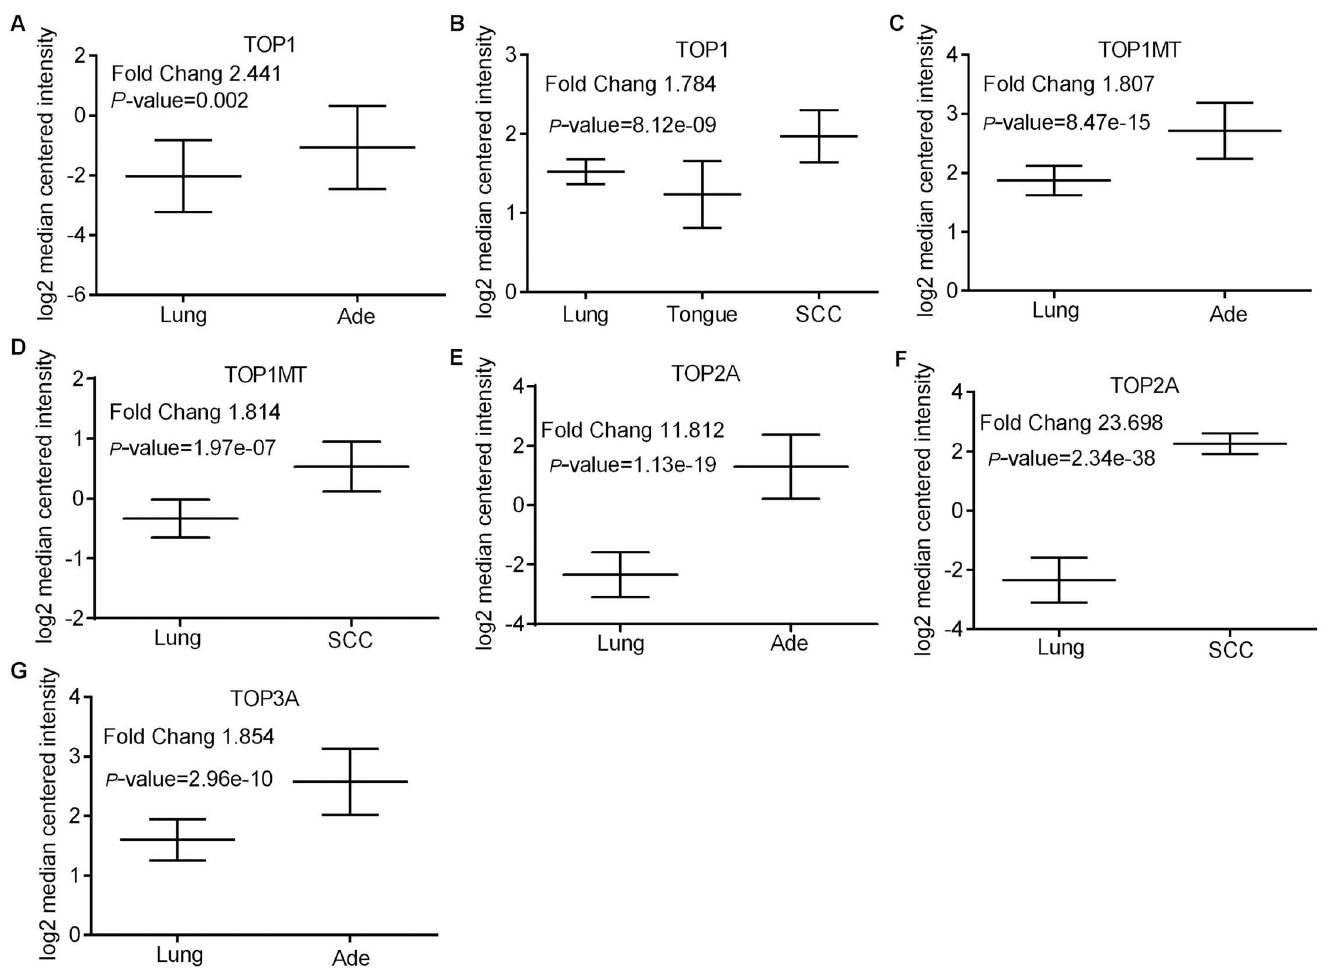
Fig 1. Topoisomerase family genes analysis in lung Adenocarcinoma (Ade) and Squamous Cell lung Carcinoma (SCC) (Oncomine database). Figures were derived from gene expressiondata in Oncomine comparingexpression levels of topoisomerase family genes in normal (left plot) and cancer tissue (right plot) and plotted using GraphpadPrism software. Y-axis represents the medianintensity, 10th and 90th percentiledata. (A) Comparisonof TOP1 mRNA expressionin Ade. (B) Comparison of TOP1 mRNA expressionin SCC. (C) Comparisonof TOP1MT mRNA expressionin Ade. (D) Comparisonof TOP1MT mRNA expressionin SCC. (E) Comparisonof TOP2A mRNA expressionin Ade. (F) Comparisonof TOP2A mRNA expressionin SCC. (G) Comparisonof TOP3A mRNA expressionin Ade.